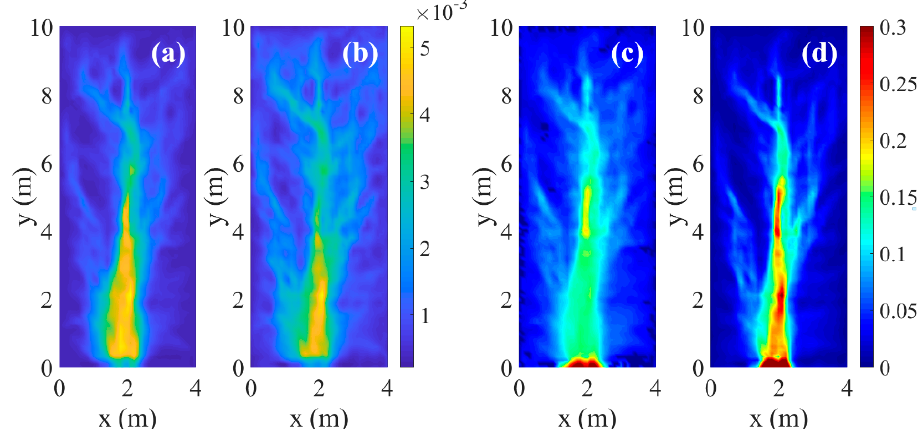
Figure 8. Computed water depths (m) using ( a ) n = 0.02 and ( b ) Equation (16). Computed flow velocity (m/s) using ( c ) n = 0.02 and ( d ) Equation (16)